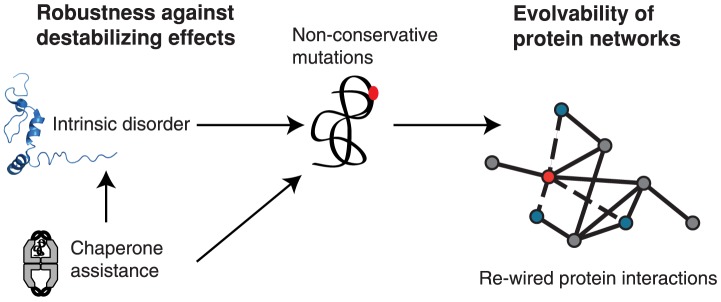
Cost-benefit trade-off in protein network evolvability.Complementary cellular quality control strategies promote non-conservative mutations, thus the evolvability of protein interactions. Intrinsically disordered proteins allow more non-conservative substitutions, but are subject to a more costly regulated turn-over to prevent their aggregation. While energetically expensive, molecular chaperones can promote non-conservative substitutions directly by buffering their destabilizing effect, or indirectly by stabilizing intrinsically disordered proteins. By conferring robustness to otherwise deleterious mutations, protein quality control mechanisms facilitate a higher number of non-conservative mutations, which increases the likelihood of evolving new protein interactions and functions.